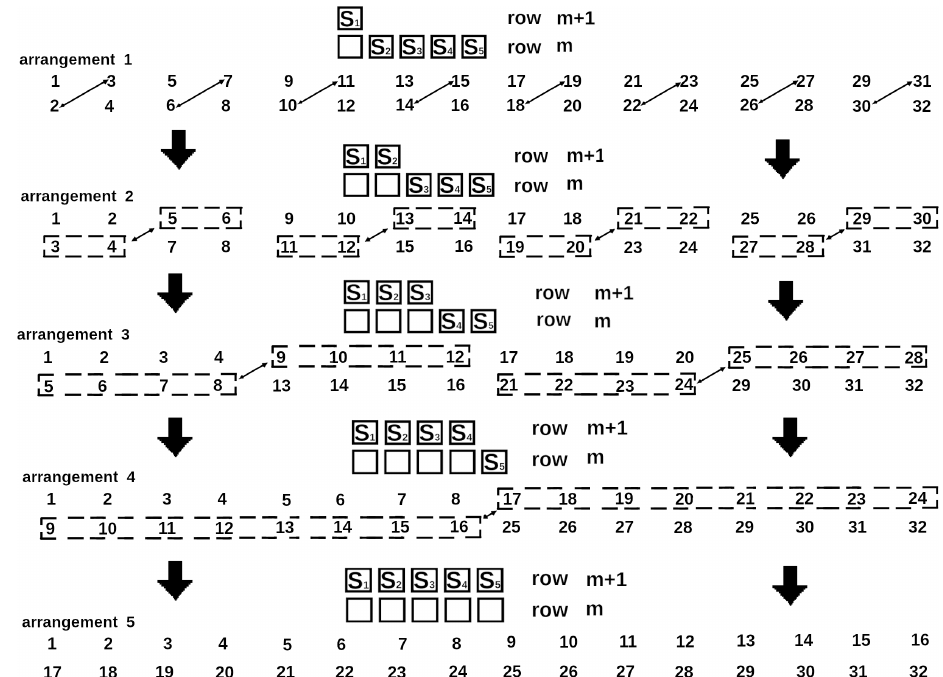
Figure 3. Splitting states of the lattice boundary spins with L x = 5 into pairs while expanding line m + 1. In this scheme, the spins of each pair are written together: one below the other. The numbers correspond to the values of E with the fixed boundaries. Position of the number corresponds to location in the memory. A pair of the cells with paired E (one below the other) are located next door to each other in the memory. Obviously all pairs of variables with E of must be in adjacent cells of the memory. sponds to a subsystem with a given number of spins of the uppermost row (a view of all 5 subsystems is shown in Figure 2). For L x = 5 we have 5 possible subsystems of different forms with spins filled from left to right (with one top spin, two, etc.). The bidirectional arrows here mean data exchange. One part takes the place of the another part, which in turn takes up the place of the first part.